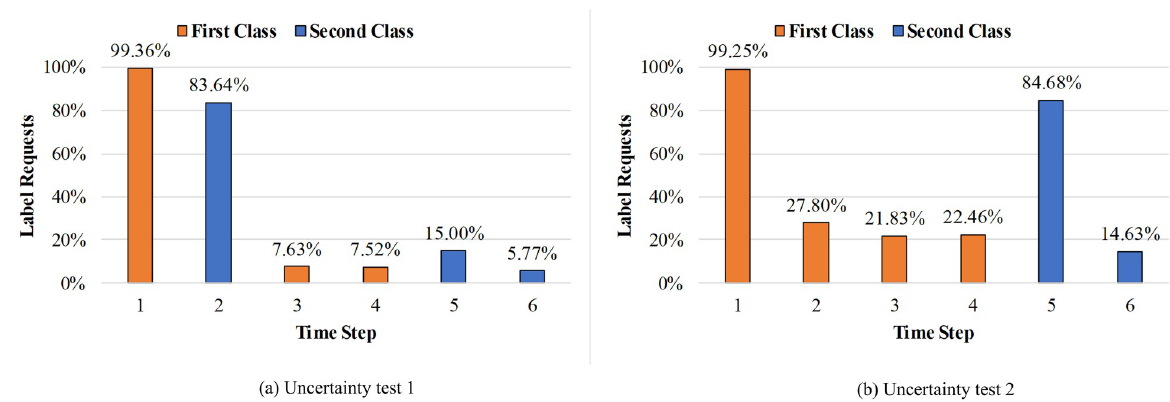
Fig 7. Second experiment results of the trained model. In this task, two random test classes were chosen for each episode. (a) At the beginning of each episode, we assigned two instances which came from different classes to the model. After that, two instances from each class was given, respectively. It shows that the request rate for later instances of the same class has been greatly reduced after the model saw an instance of that class. (b) 4 instances from the first class were presented, followed by 2 instances from the second class. The label request rate at time step 2 is greatly reduced, and the label request rate at time step 5 is greatly increased.